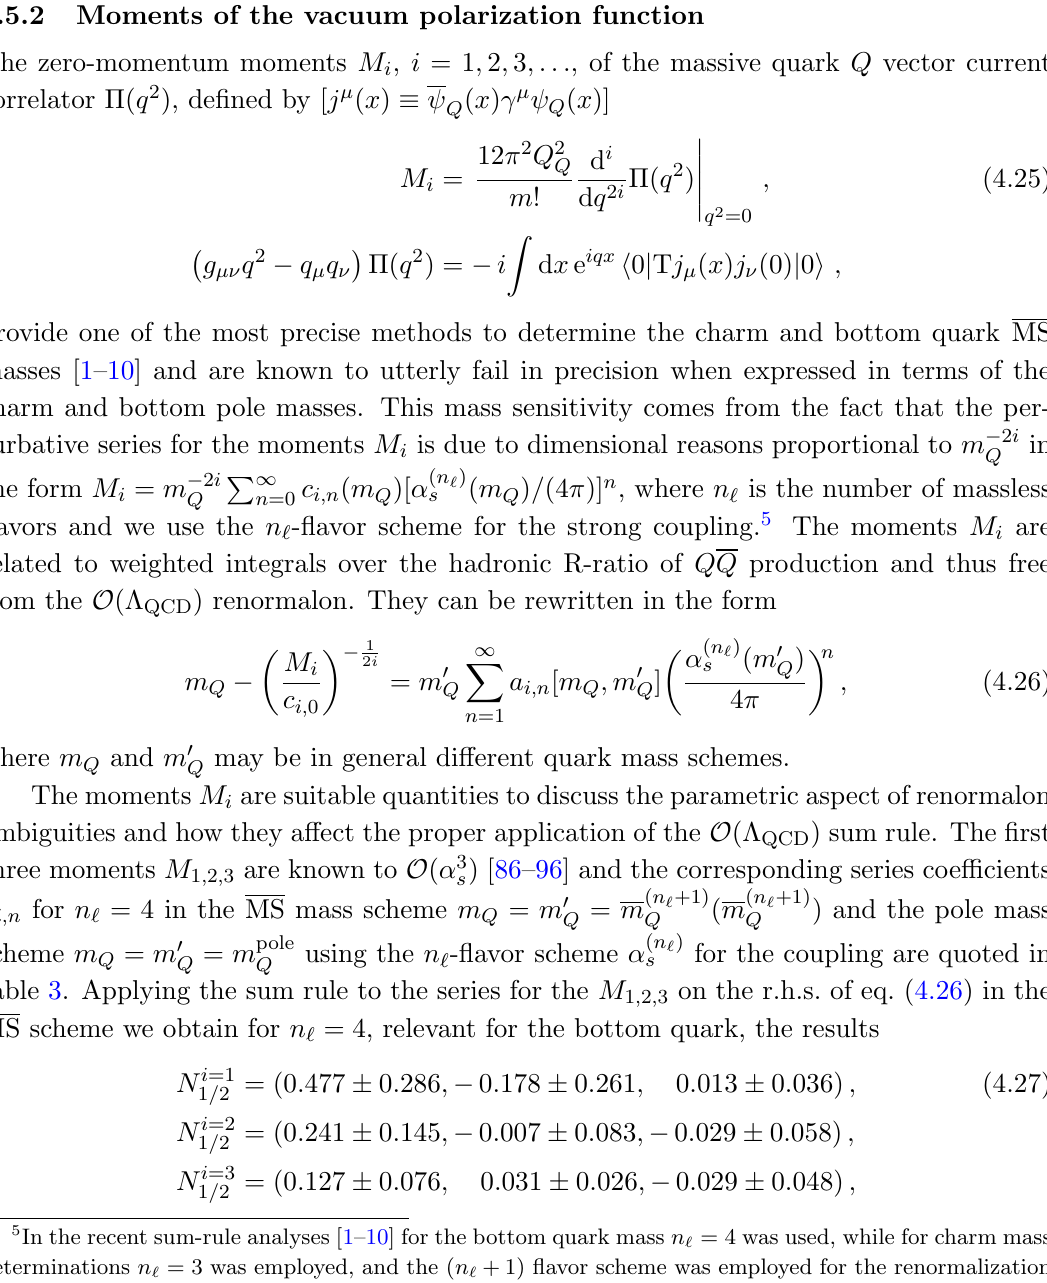
table 3. Applying the sum rule to the series for the M MS scheme we obtain for n